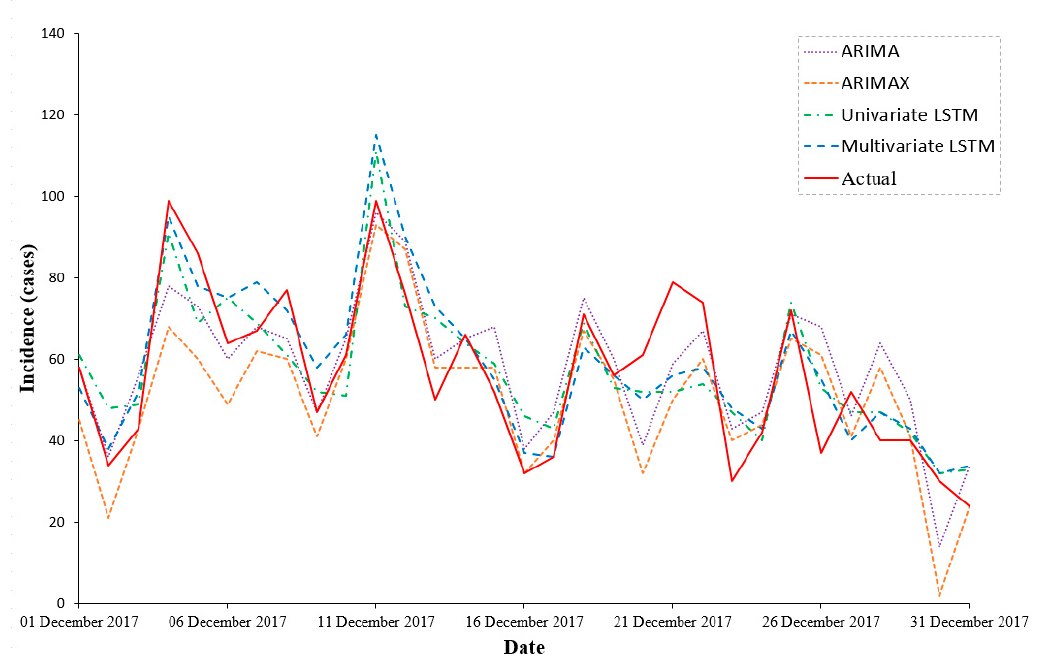
Figure 5. The actual daily incidence of HFMD and values predicted by the four models in December 2017.